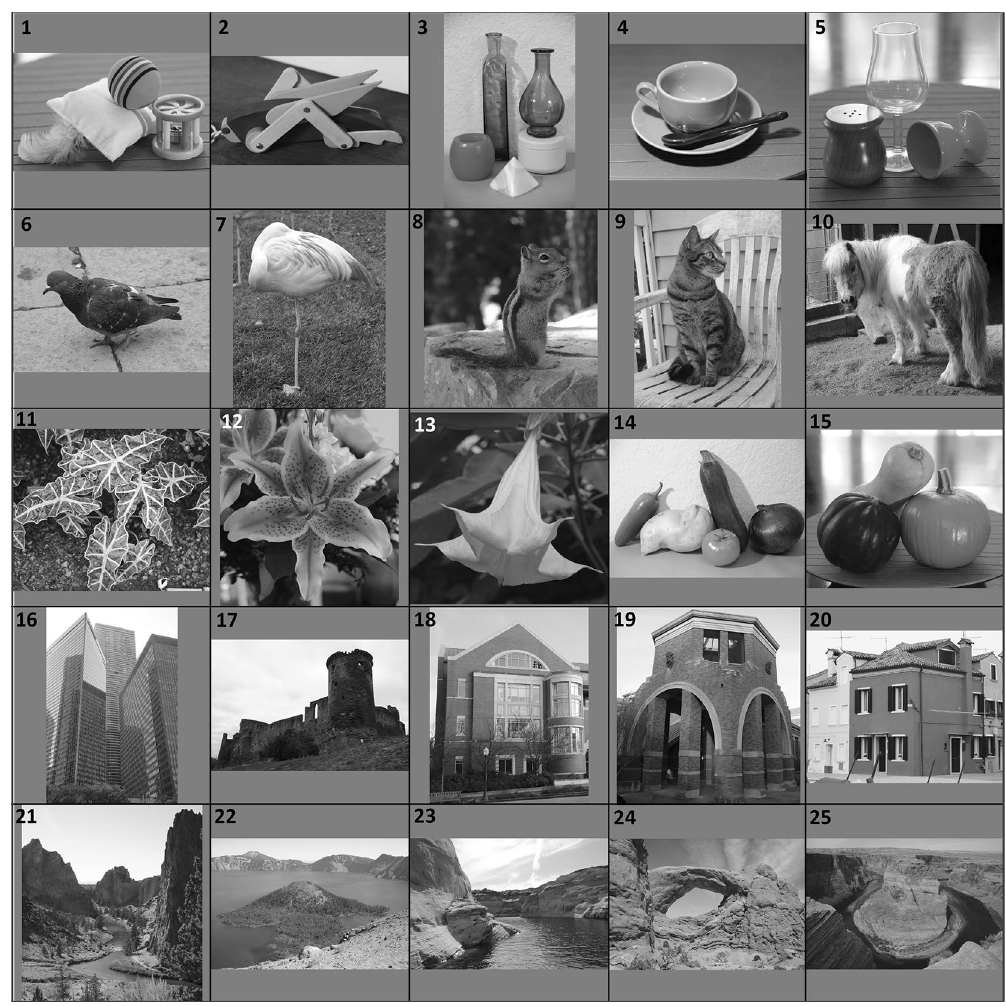
Figure 2. Photographs for the drawing task. Photographs were presented one at a time in random order and consisted of 5 categories—objects (still-life) (1–5), animals (6–10), plants (11–15), buildings (16–20), and natural scenes (landscapes) (21–25)—with 5 photographs from each category. All 25 images were presented for one minute each and participants were instructed to focus on accurately recreating the main lines, angles, and proportions of each image to the best of their